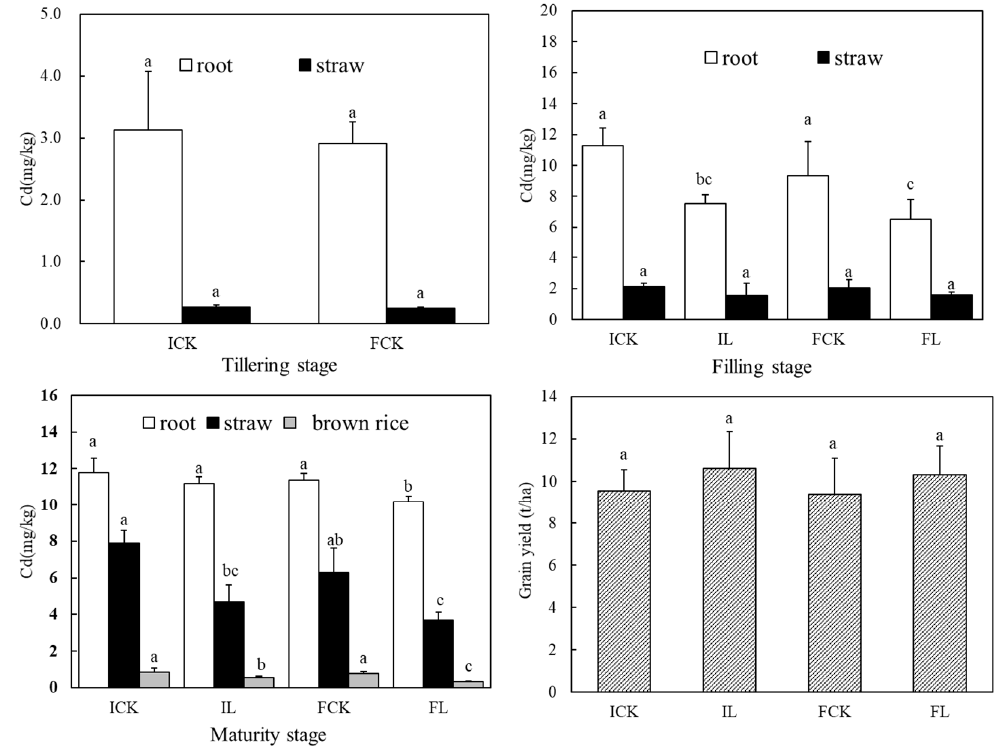
Figure 1. Cd concentration in rice tissues at different growth stages of rice and rice grain yield. ICK, IL, FCK, and FL are the intermittent treatment, lime combined with intermittent treatment, the flooding treatment, and lime combined with flooding treatment, respectively. Data are means ± SD of three replicates. Bars with different letters indicate a significant difference ( p < 0.05).